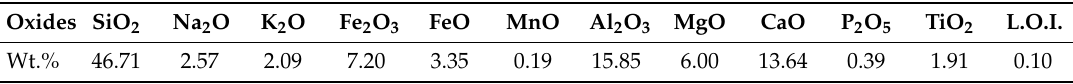
Figure 3. View (3–66° 2 θ ) of the Rietveld plots of the ash data collected. The blue curve (below) represents the glass. The grey curve represents the difference between observed and calculated plots. Vertical bars mark the position of calculated Bragg reflections of (from top to bottom) plagioclase (albite, anorthite), pyroxene (augite), and olivine. Table 1. Chemical composition of major and minor elements of Etna ash (volcano eruption 2001) by XRF analysis (wt.%). L.O.I = loss on ignition.